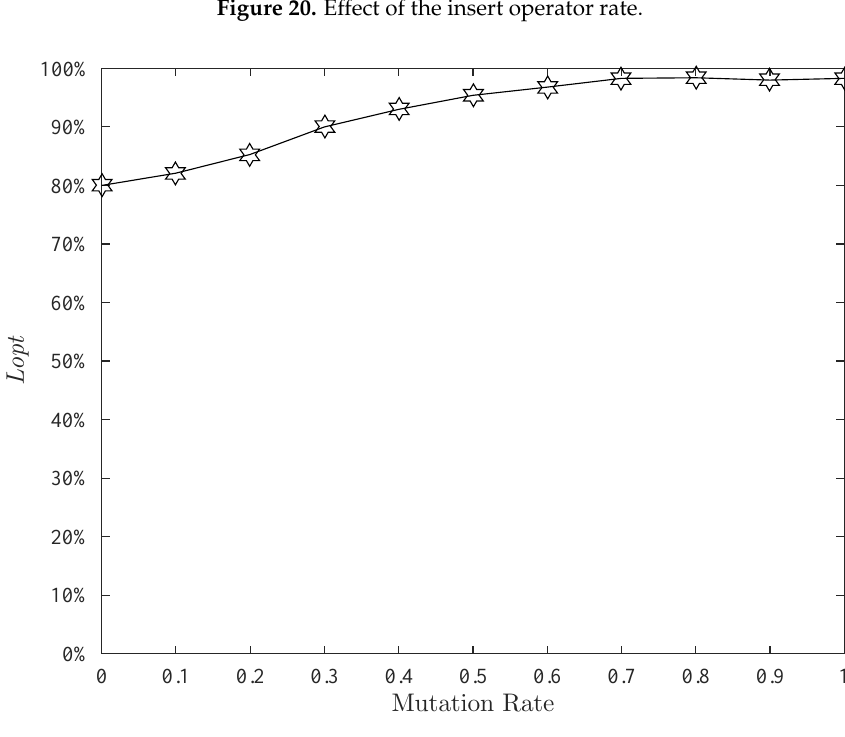
Figure 21. Effect of the mutation